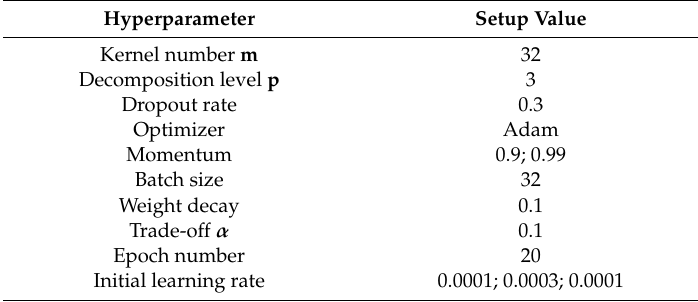
Table 3. Overviews of the hyperparameter setups.